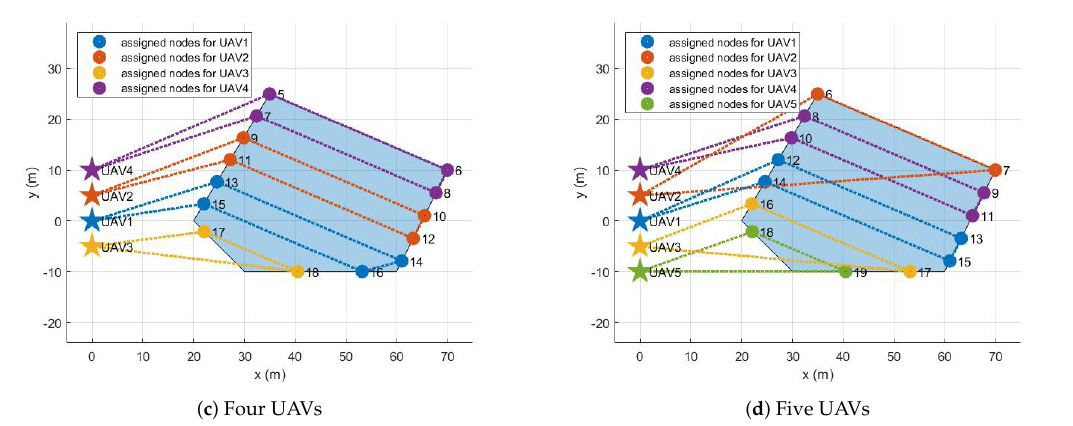
Figure 7. Assignment results for pentagon.